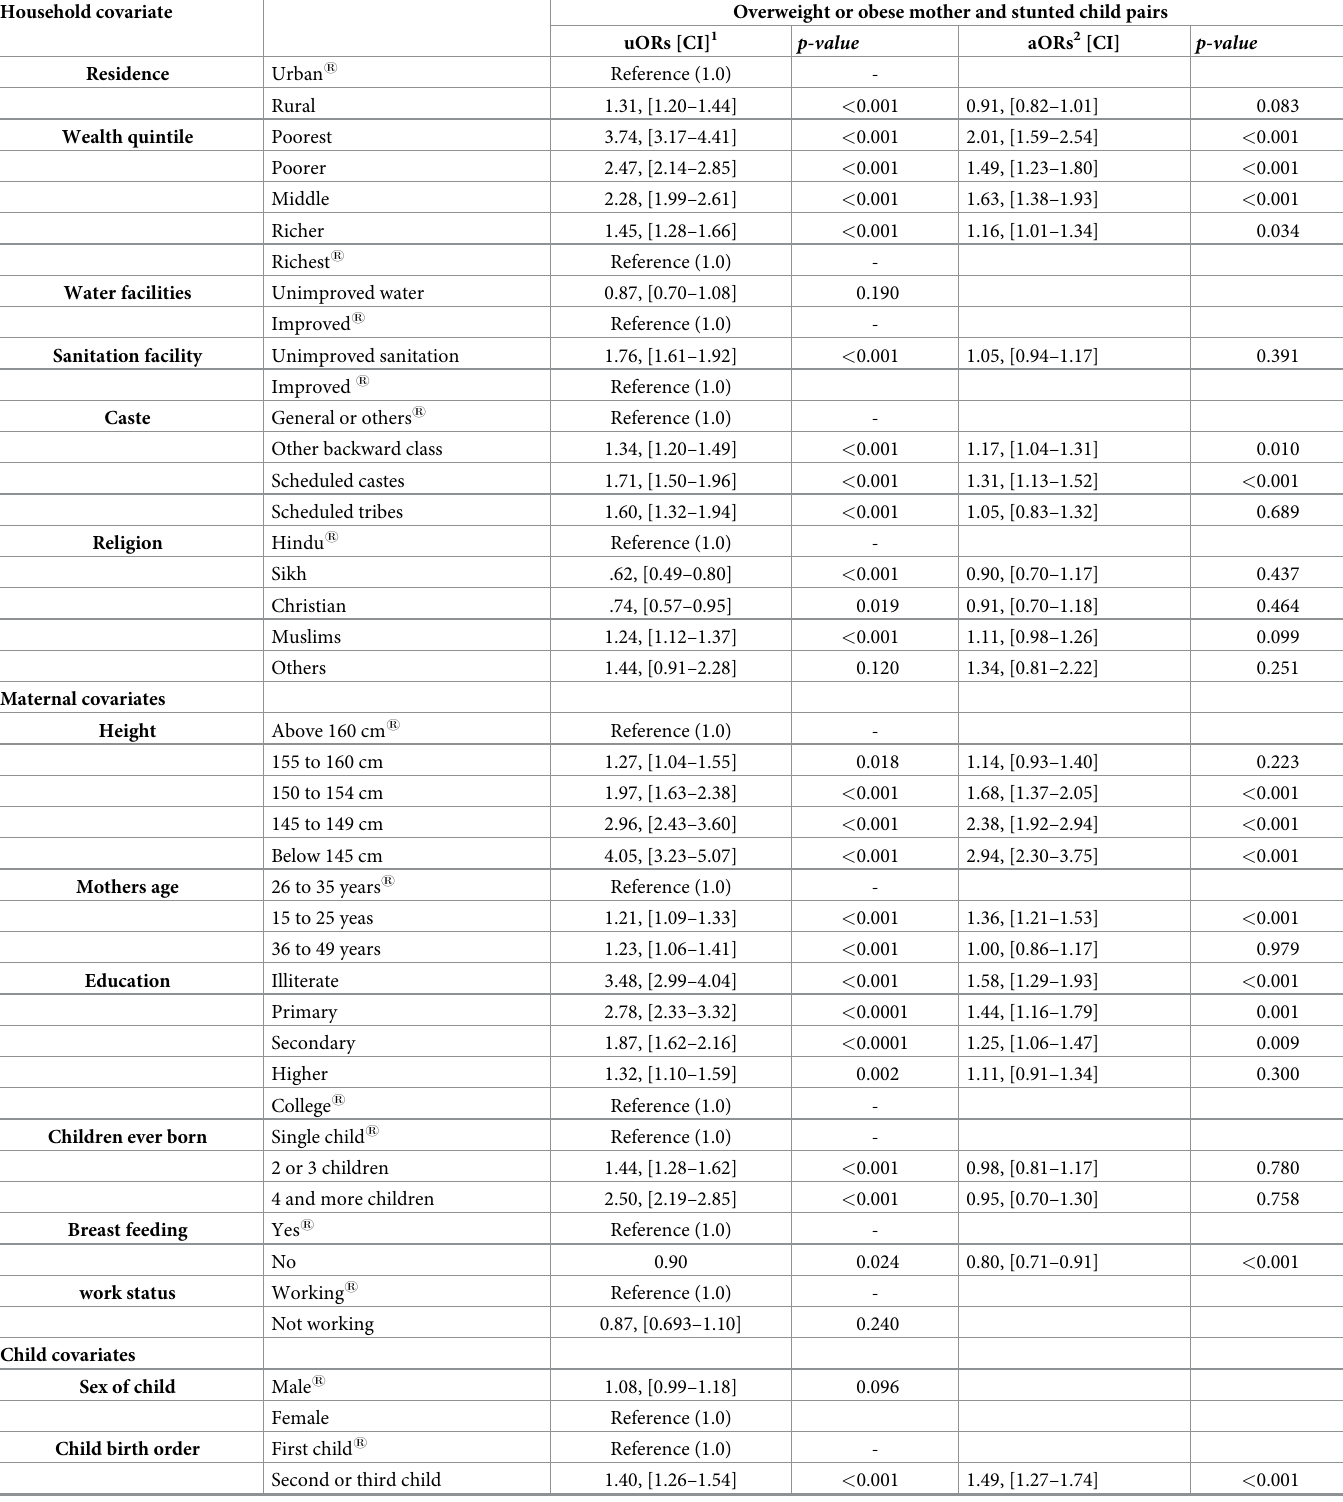
Table 4. Logistic regression results of overweight /obese mother and stunted child by familial, maternal, and child covariates. Household